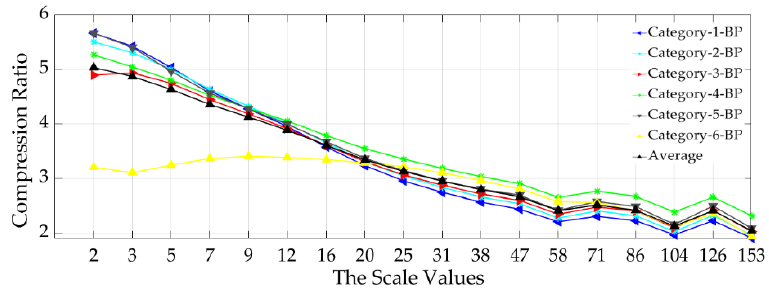
Figure 15. Relationship between the scale of analysis and the six surface categories compression performance by using the multiscale low-pass (LP) data sets.